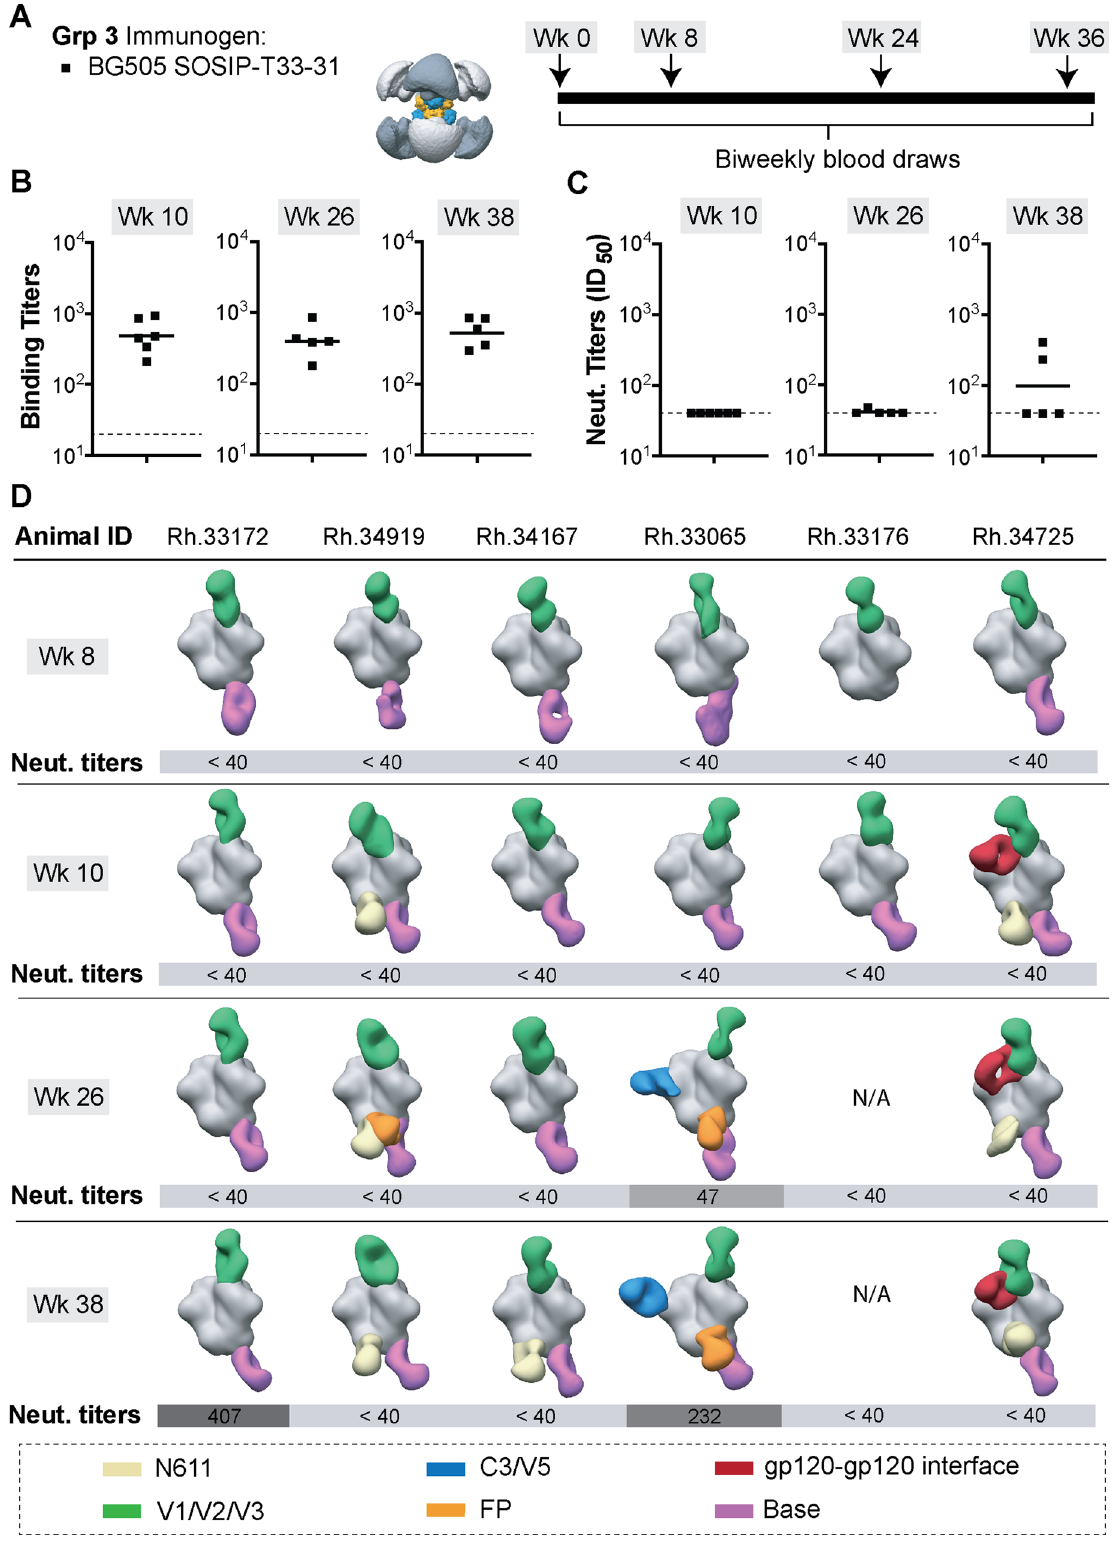
Fig. 6 Immunization experiments with the octameric BG505 SOSIP-T33-31 nanoparticle. A Immunization information and schedule. B ELISA binding titers (midpoint) and C neutralizing antibody titers (ID 50 ) for plasma samples collected at time points indicated above each graph. Horizontal lines represent the geometric mean values at each time point ( n = 6 animals for week 10 and n = 5 animals for weeks 26 and 38; see Method section for details). ELISA and pseudovirus neutralization experiments were performed in triplicates ( n = 3) for each serum sample at every time point and the mean value is plotted. C Composite fi gures from nsEMPEM analysis of polyclonal responses at weeks 8, 10, 26, and 38. Animal IDs are shown above each dataset. Neutralizing antibody titers for corresponding animals are shown below each composite fi gure. A color-coding scheme for antibodies targeting different epitope clusters is shown at the bottom. BG505 SOSIP antigen is represented in